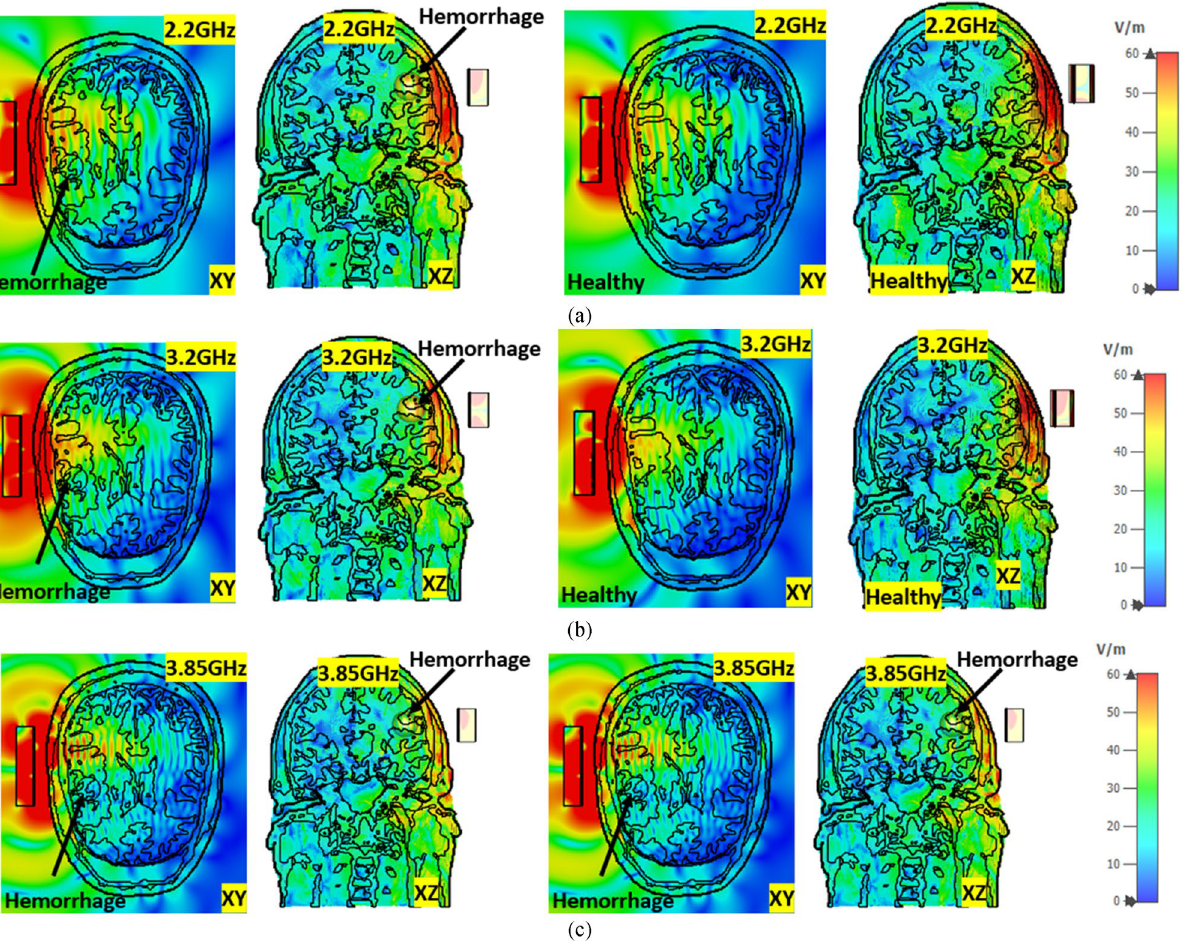
Figure 11. E-field distribution of healthy and unhealthy head at ( a ) 2.2 GHz, ( b ) 3.2 GHz, and ( c ) 3.85 GHz,